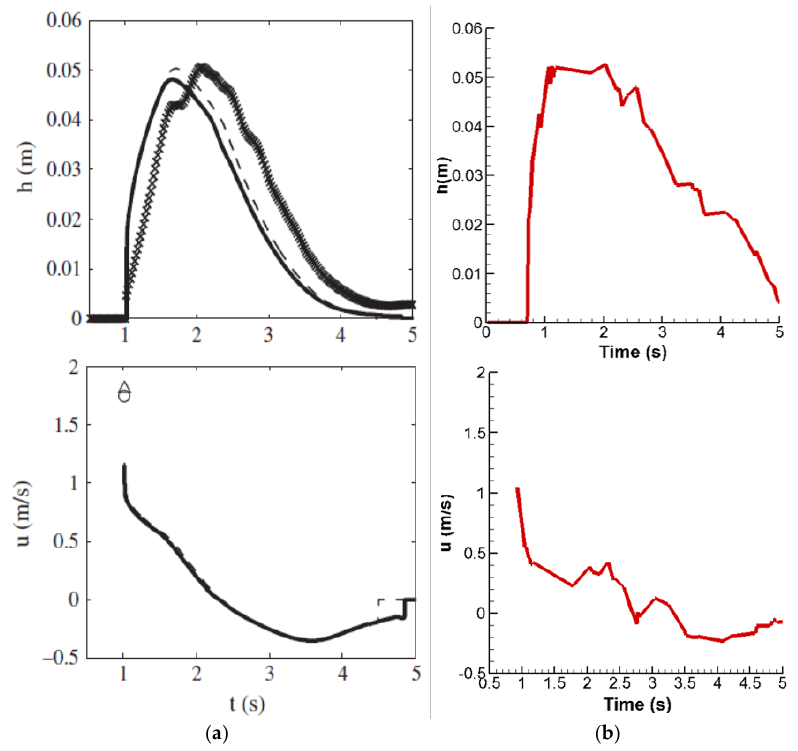
Figure 12. Time history of change of height and velocity from ( a ) experiment and ( b ) numerical simulation.